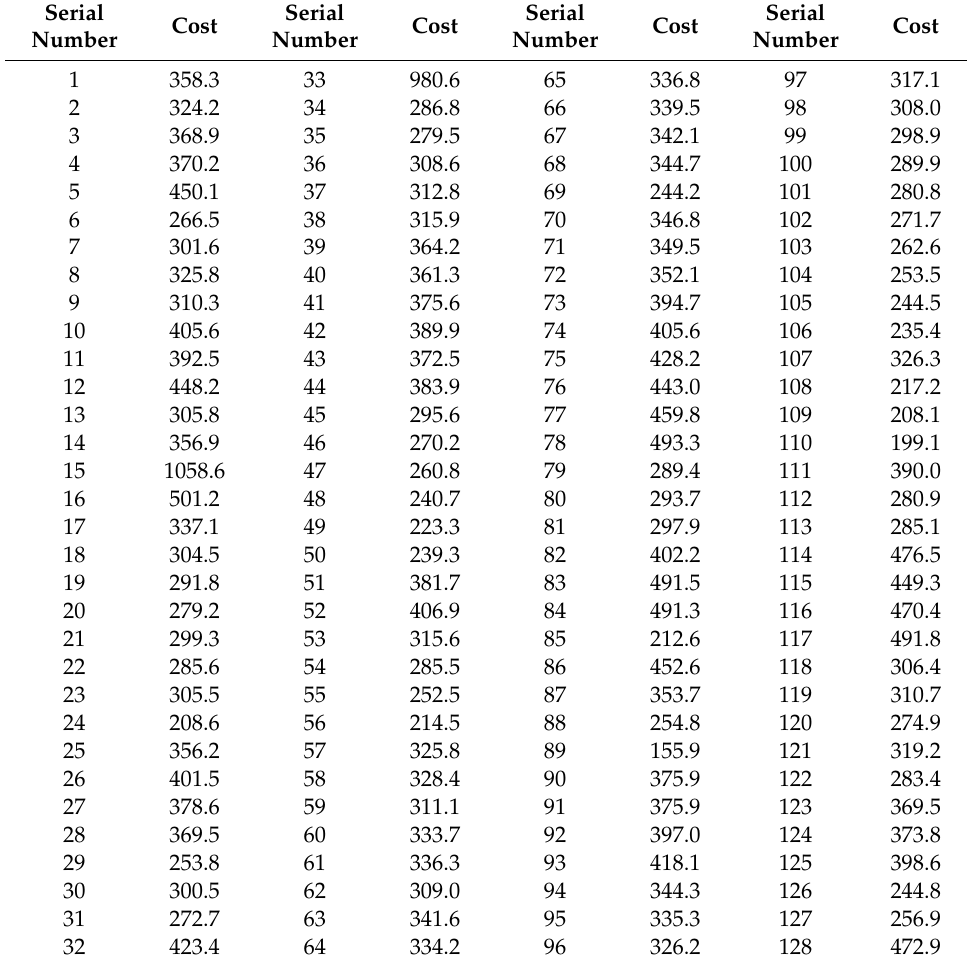
Table 1. Original cost data of projects (Unit: CNY / kV ·